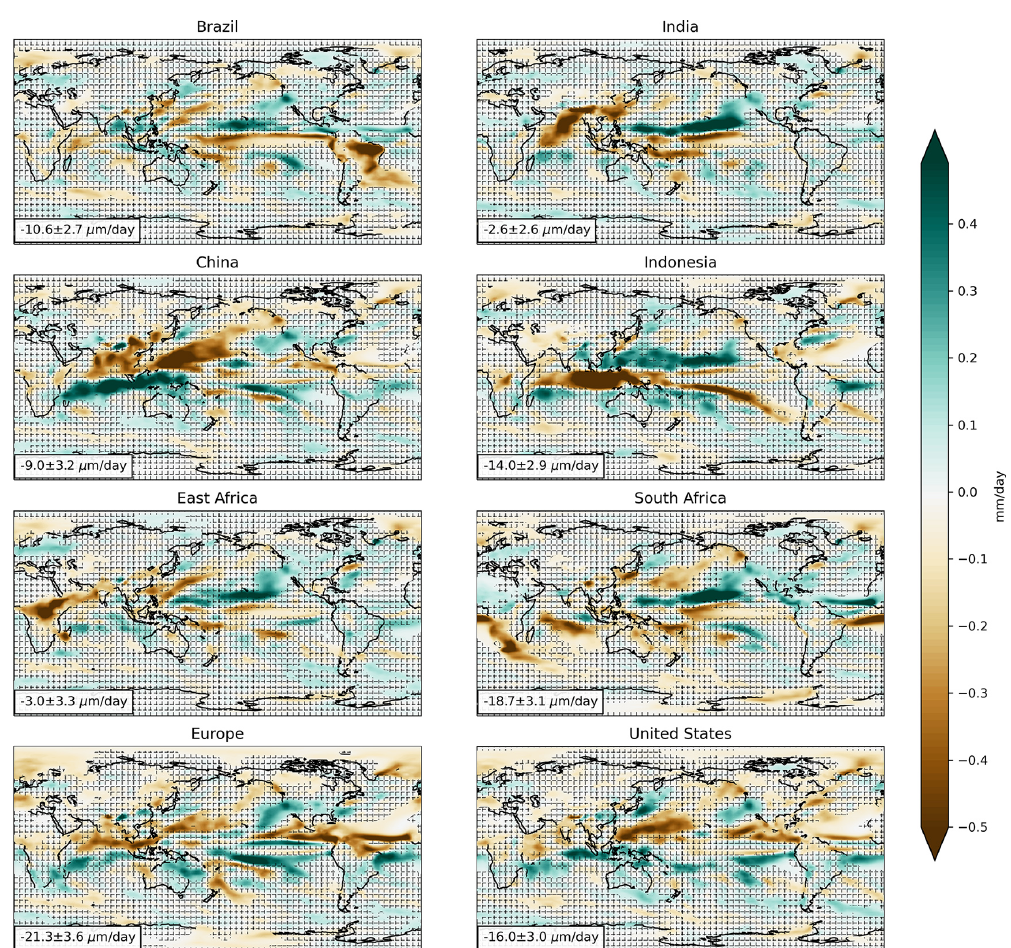
Figure 1. Spatial distribution of the change in precipitation rate (mmd − 1 ) due to the addition of an identical amount and composition of aerosol emissions in each of the eight regions. Grid lines indicate regions where the changes are not statistically significant at the 95% confidence level via a two-sided t test. Global-mean precipitation rate change and 95% confidence intervals ( ± 1 . 96 σ ) (µmd − 1 ) are shown in the bottom left corner of each